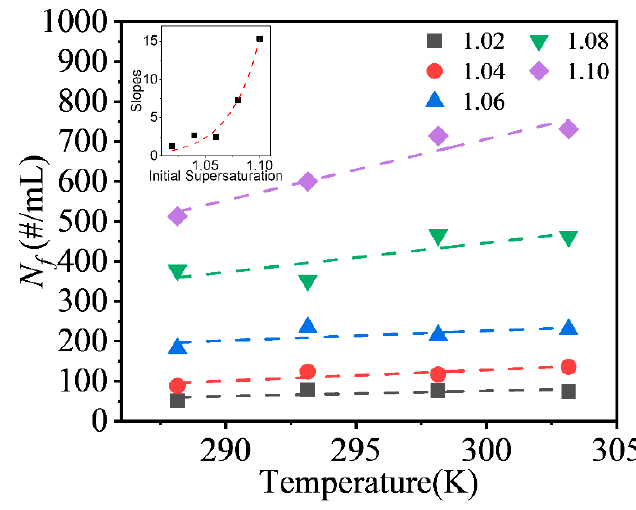
Figure 8. Final crystal suspension density of experiments conducted with 5 crystal seeds at 200 rpm.